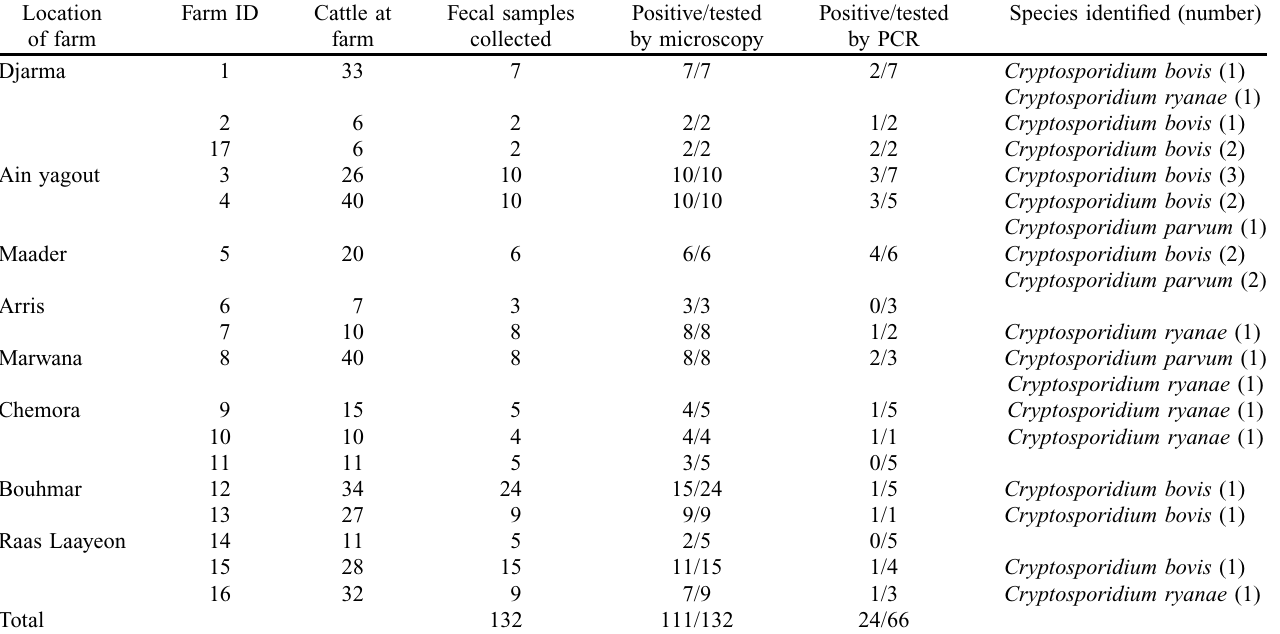
Table 1. Cryptosporidium species identified in dairy cattle in